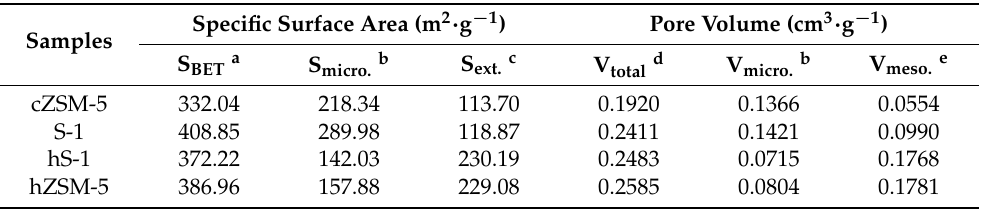
Figure 3. ( a ) N 2 adsorption and desorption isotherms and ( b ) pore size distributions of different zeolites. Table 1. Textual properties of various supports.